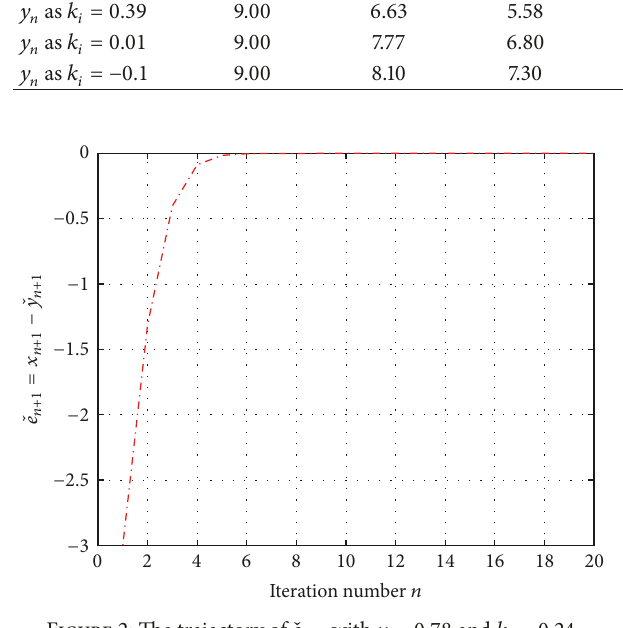
Figure 2: The trajectory of ̌𝑒 𝑛+1 with 𝜇 = 0.78 and 𝑘 𝑖 = 0.24 .